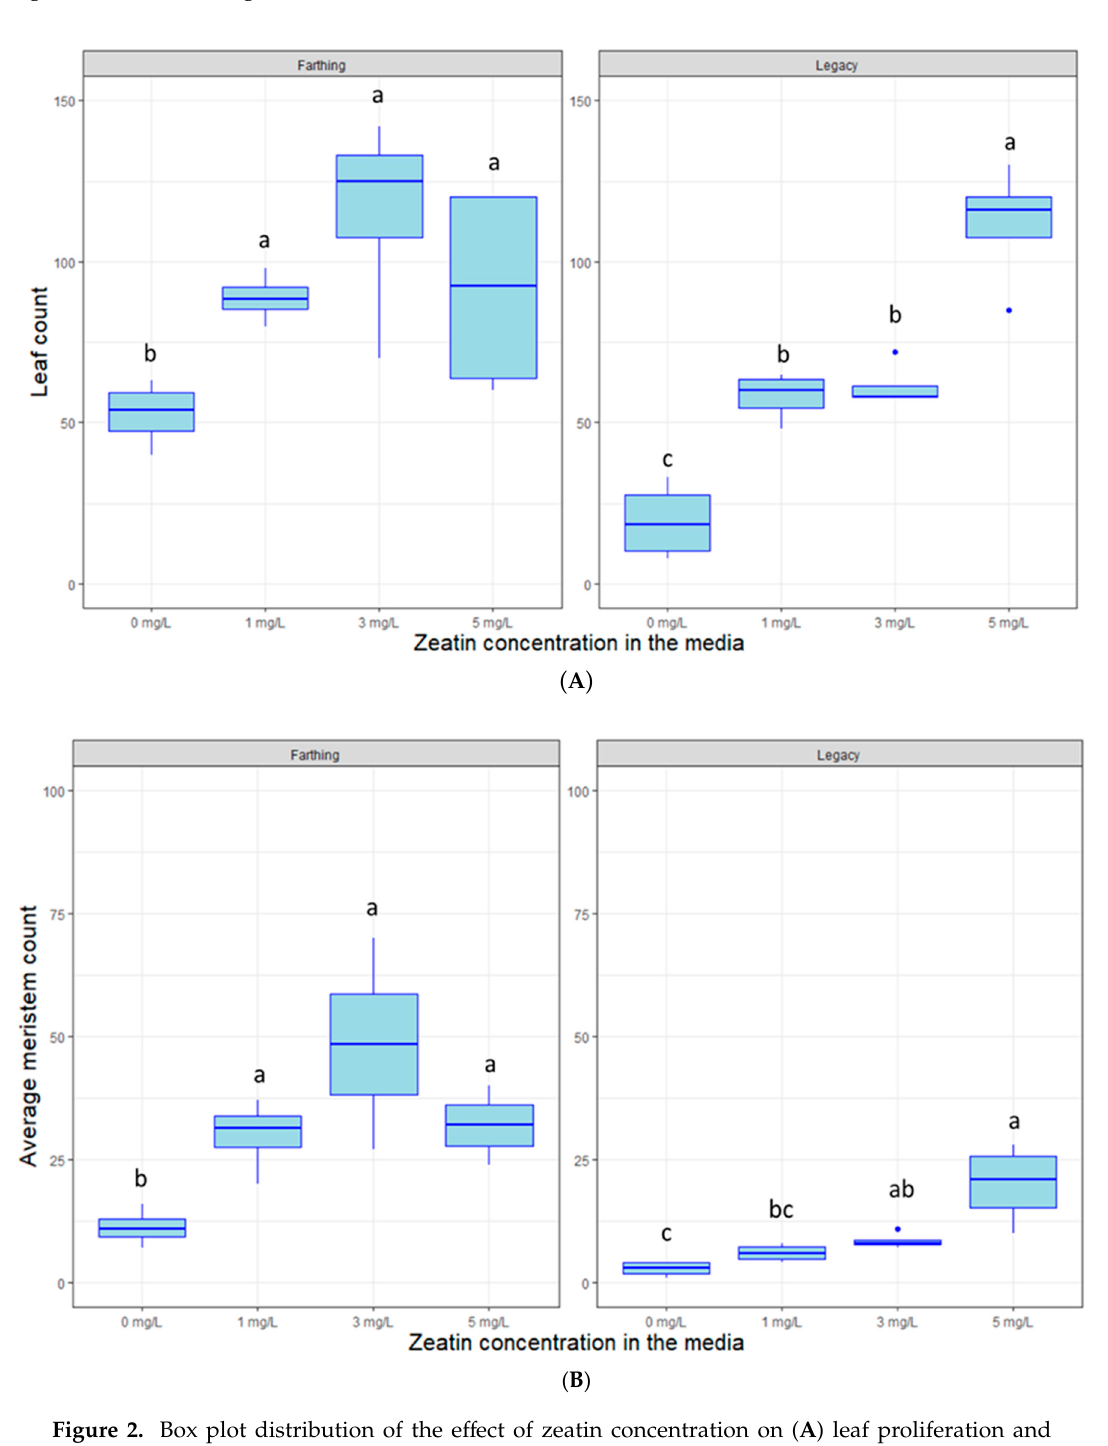
Figure 2. Box plot distribution of the effect of zeatin concentration on ( A ) leaf proliferation and ( B ) meristem proliferation in blueberry genotypes “Farthing” (left panels) and “Legacy” (right panels) grown in tissue culture. Letters above boxplots indicate multiple comparison test. Treatments with the same letters are not statistically different at alpha = 0.05.